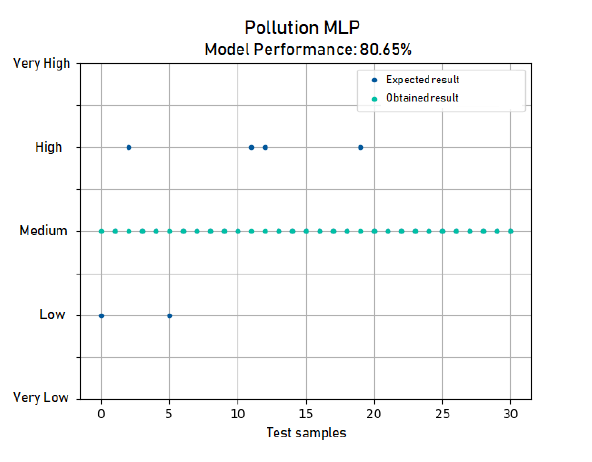
Figure 15. MLP for Pollution. Model Performance: